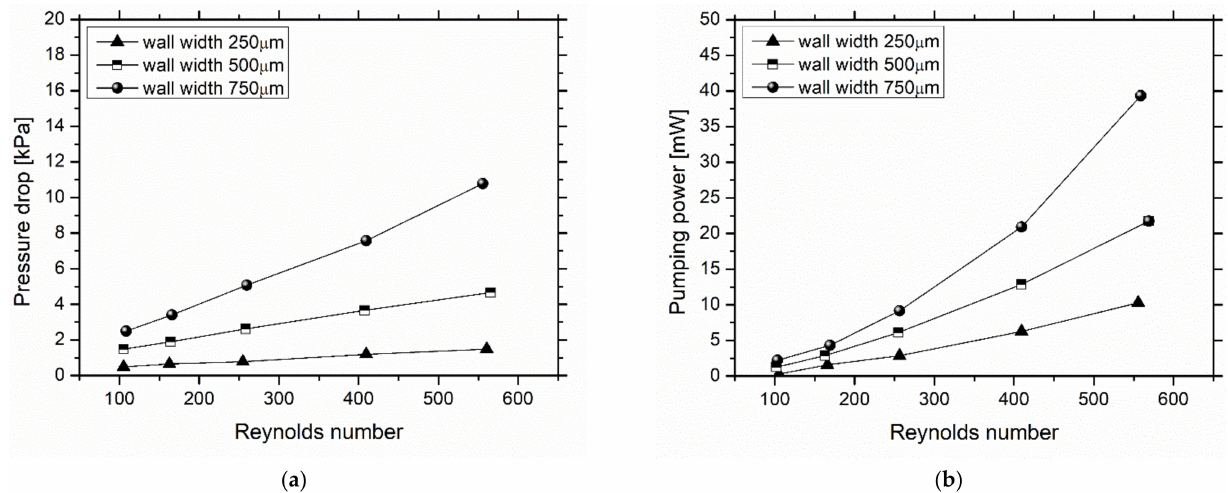
Figure 3. Effect of the wall width on: ( a ) pressure drop and ( b ) pumping power for single-phase water flow in the heat sink.